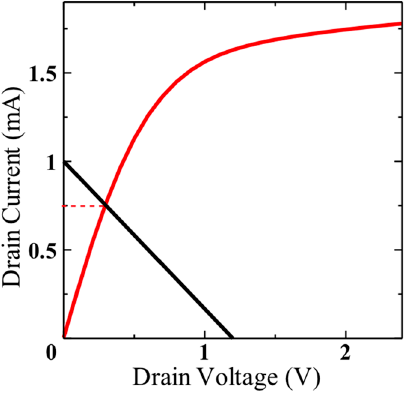
Figure 7. The transistor characteristics (red) and load line (black) of the 2 µm spin-SLM.